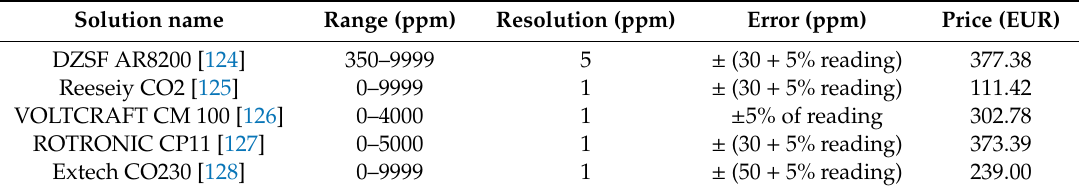
Table 5. Portable CO 2 monitoring systems available on the